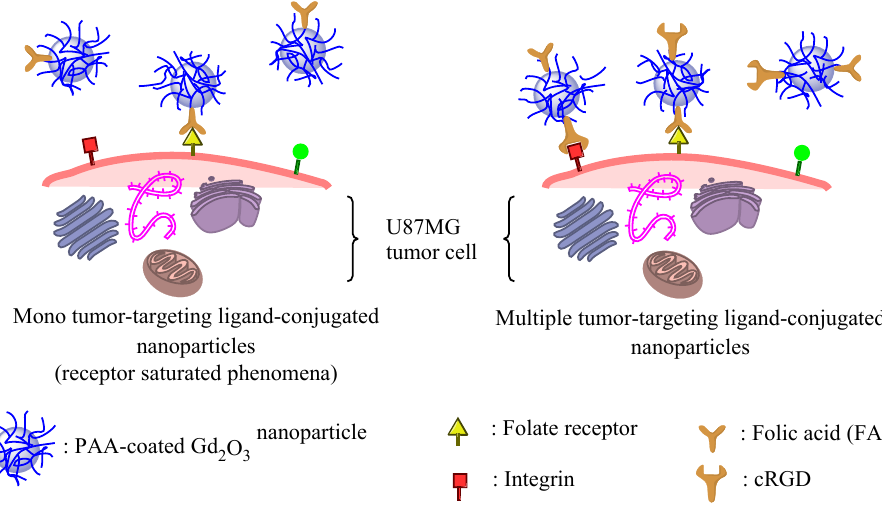
Figure 10. Schematic diagram showing enhanced tumor imaging by the cRGD/FA-PAA-Gd 2 O 3 na- noparticles ( right ) compared with the FA-PAA-Gd 2 O 3 nanoparticles ( left ). nanoparticles ( right ) compared with the FA-PAA-Gd 2 O 3 nanoparticles ( left